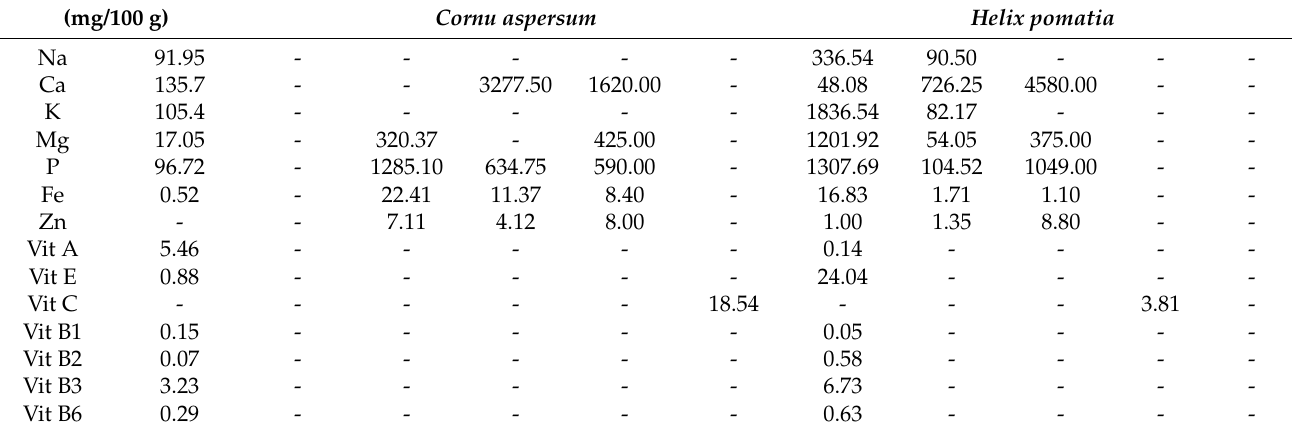
Table 2. The mean share of elements and vitamins in the meat of edible